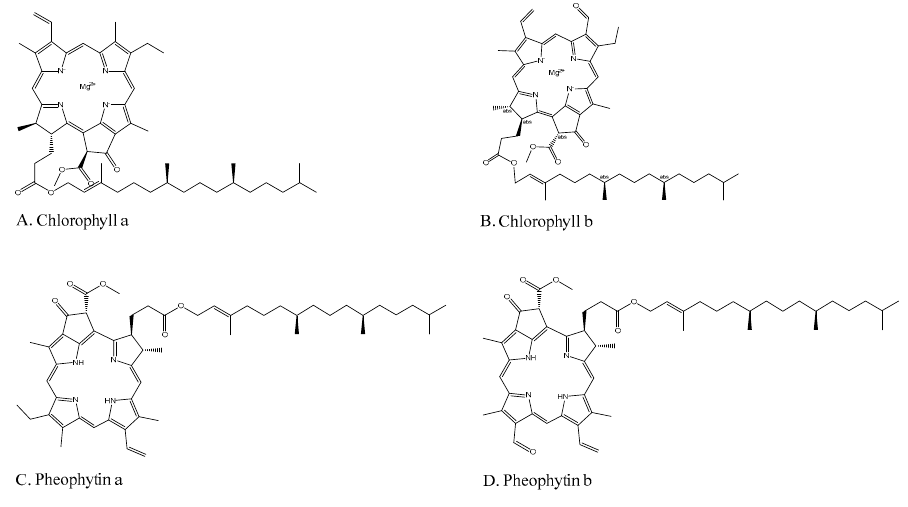
Figure 4. Structures of chlorophyll derivatives.